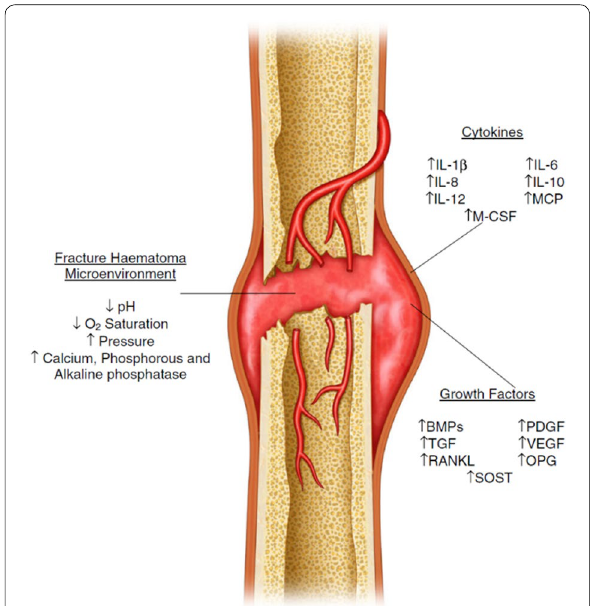
Fig. 2 Diagrammatic representation of fracture haematoma composition. Key: IL interleukin, MCP monocyte chemoattractive protein, M-CSF monocyte colony-stimulating factor, BMP bone morphogenic protein, PDGF platelet-derived growth factor, VEGF vascular endothelial growth factor, RANKL receptor activator of nuclear factor kappa-B ligand, OPG osteoprotegerin, SOST sclerostin (Adapted from Walters et al. [34] used with